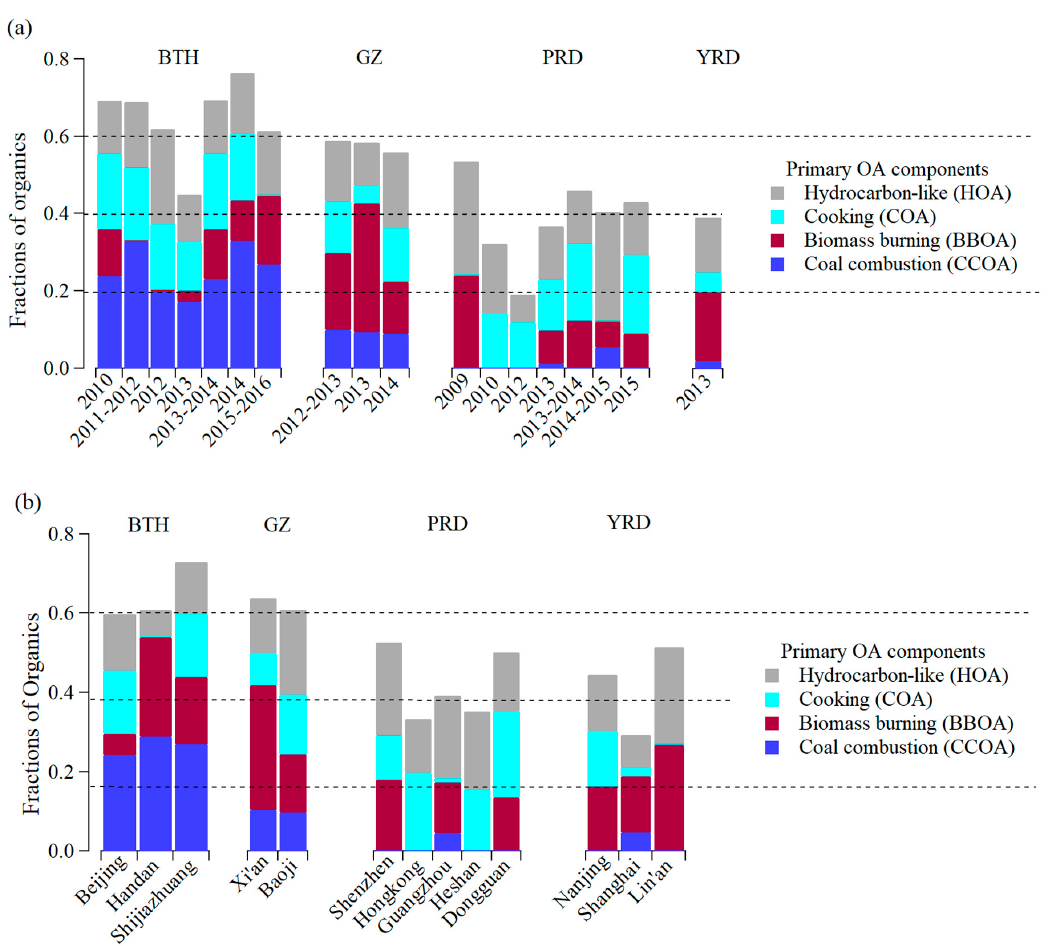
Figure 4. Relative contributions of primary organic sources to total organics in ( a ) different years and ( b ) different cities across the four regions.